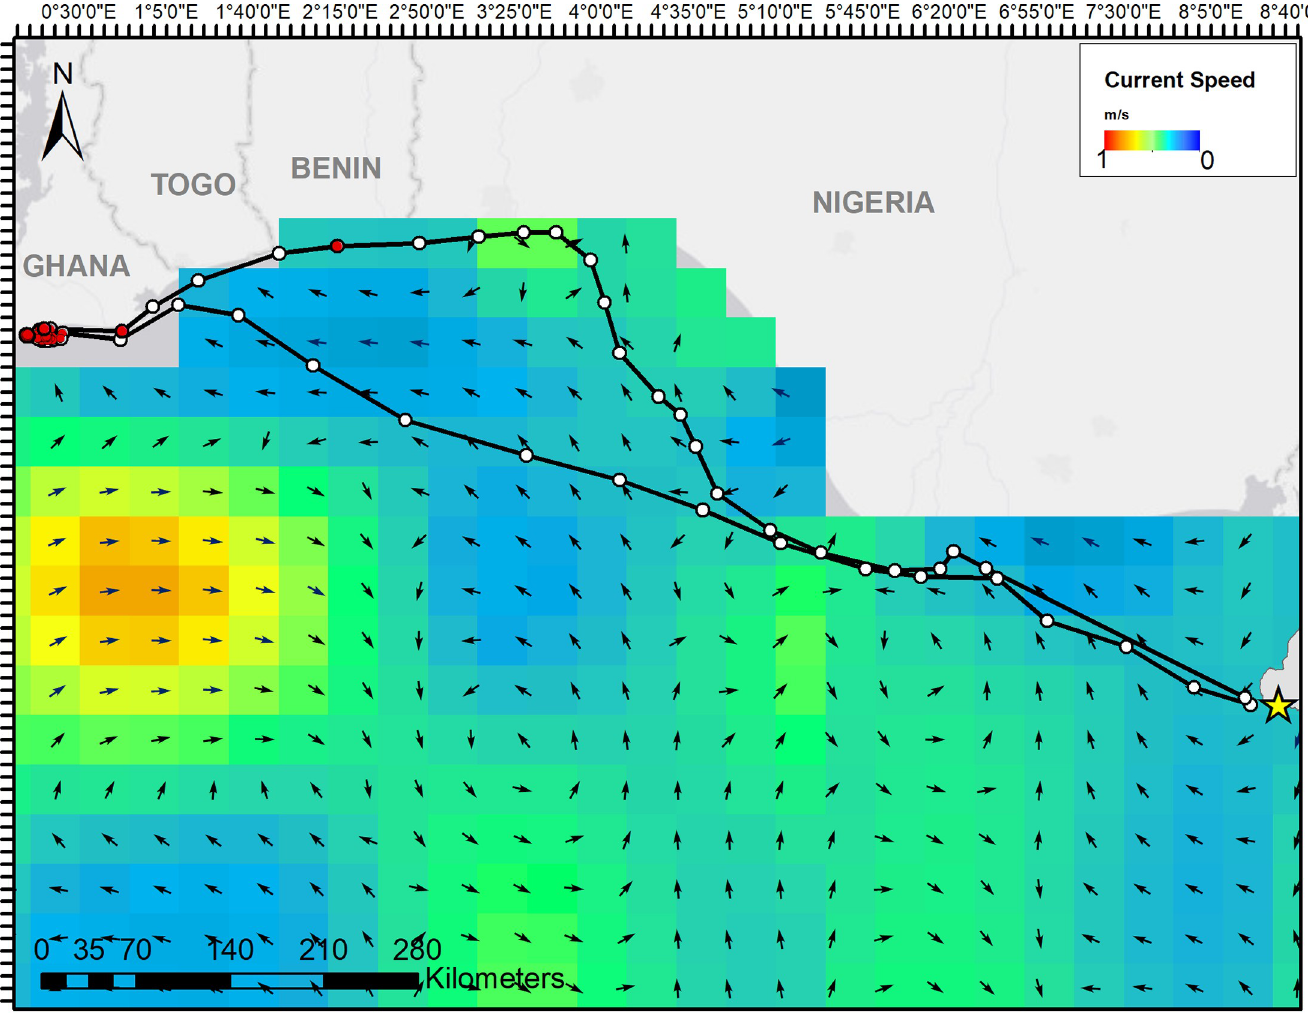
Fig 4. Ocean currents and daily locations (circles) of two green turtles tracked by satellite from Bioko Island across the Bight of Benin. One coastal and one oceanic migration route are overlaid onto averaged ocean surface current data for the 10 day period from 10–20 Feb 2018. White circles represent migrating behavior and red circles represent foraging behavior, as identified by the state-space model. Arrows represent current direction.